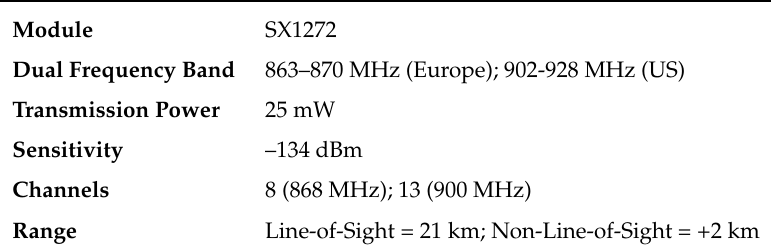
Table 5. LoRa technology hardware description